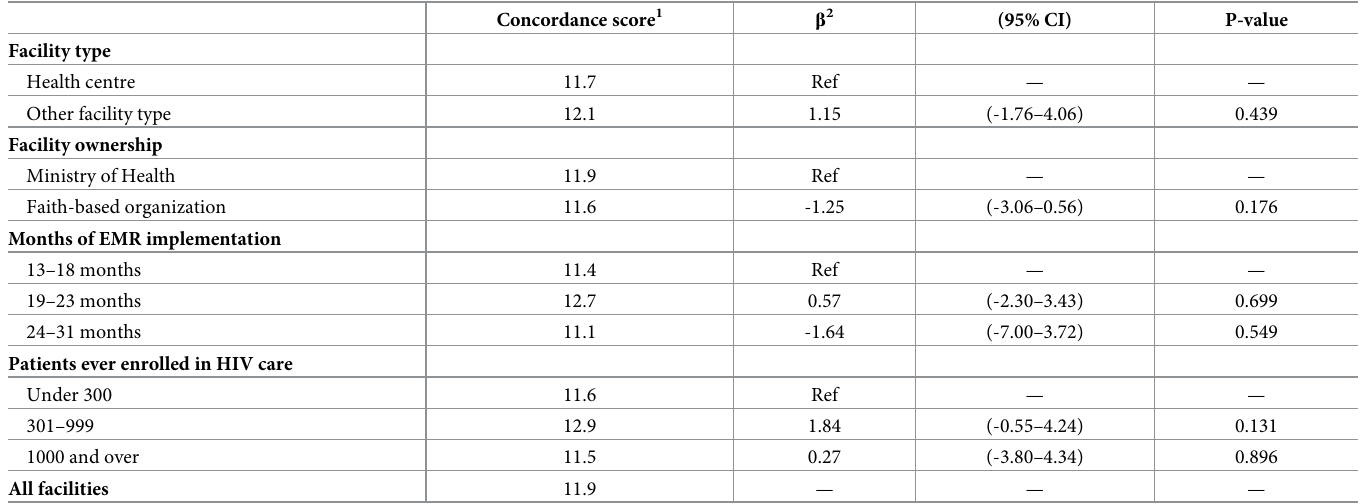
Table 3. The association between facility characteristics and the frequency of concordant data elements in paper records and KenyaEMR during baseline RDQAs.